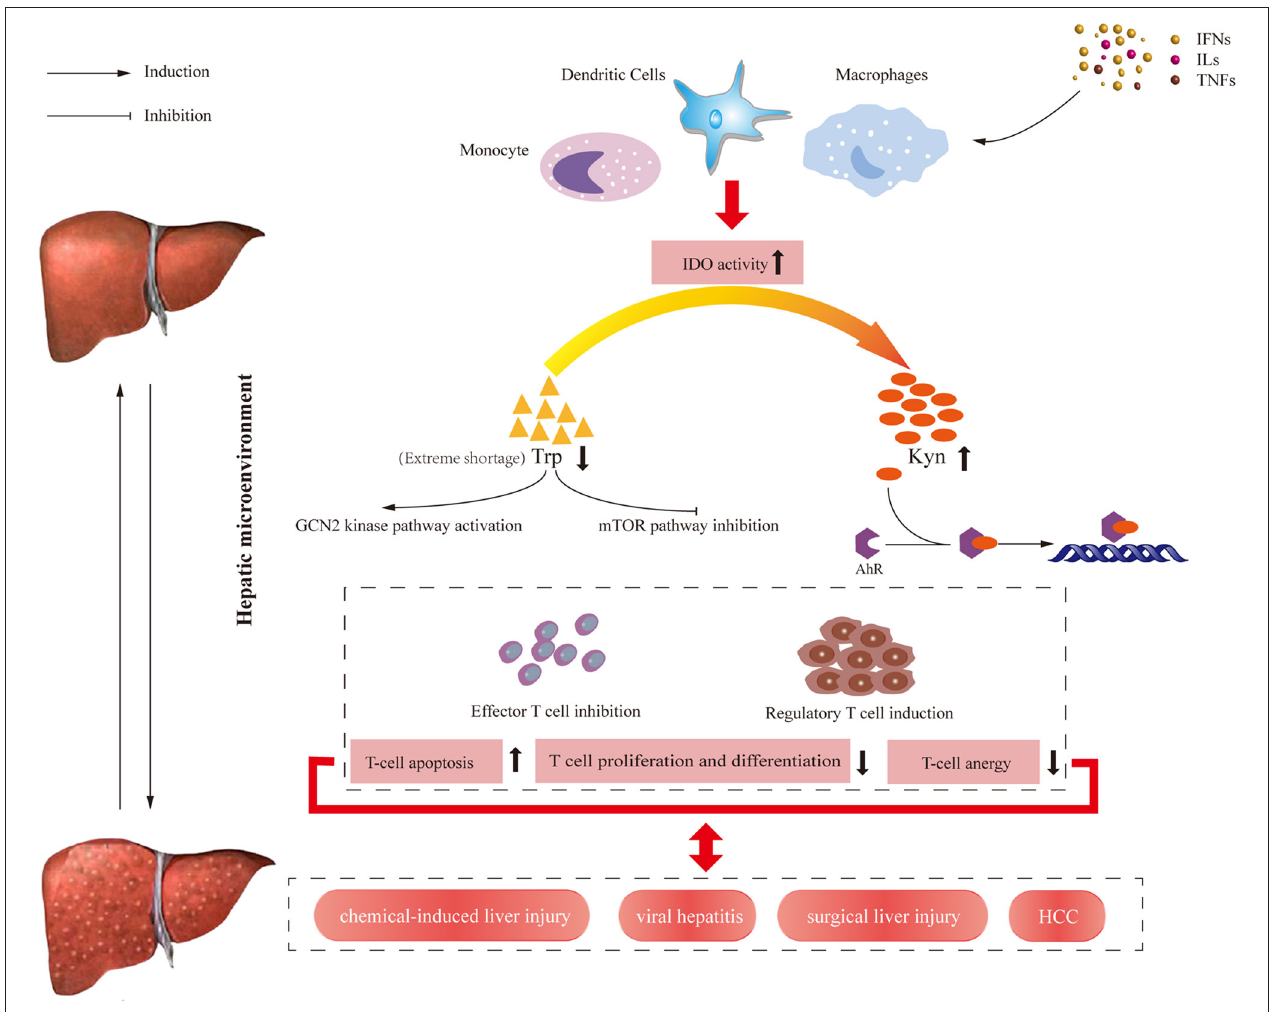
FIGURE 2 | Overview of immune regulation pathways induced by IDO enzyme in humans. At the transcriptional level, IDO enzyme is expressed by various cells of the immune system and activated by cytokines and other immunomodulatory molecules such as TNF- α , IL-6, and IFN- γ . On the one hand, IDO activity results in decreasing available Trp level, which activates the GCN2 kinase pathway and inhibits the mTOR pathway, leading to the reduced number of antigen-specific T cells. On the other hand, increasing Kyn level and KP metabolite concentrations induced by IDO activate AHR pathway, leading to the increased number of regulatory T cell. The results of these signal pathways contribute to the apoptosis of effector T cells and proliferation regulatory T cells. IFNs, interferons; ILs, interleukins; TNFs, tumor necrosis factors; IDO, Indoleamine 2,3-dioxygenase; HCC, hepatocellular carcinoma; Trp, tryptophan; Kyn, kynurenine; GCN2, general control non-depressible; AHR, aryl hydrocarbon receptor; mTOR, mammalian target of